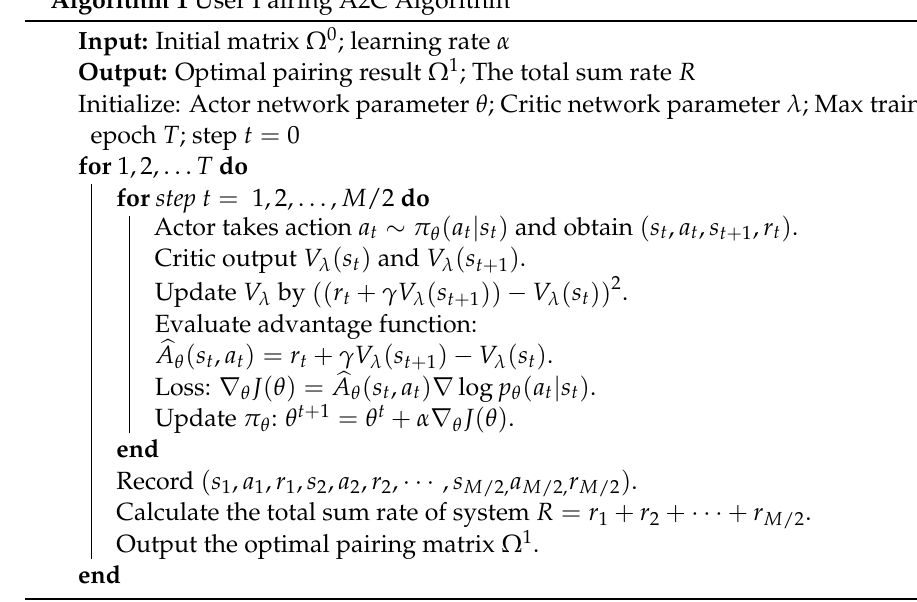
Algorithm 1 User Pairing A2C